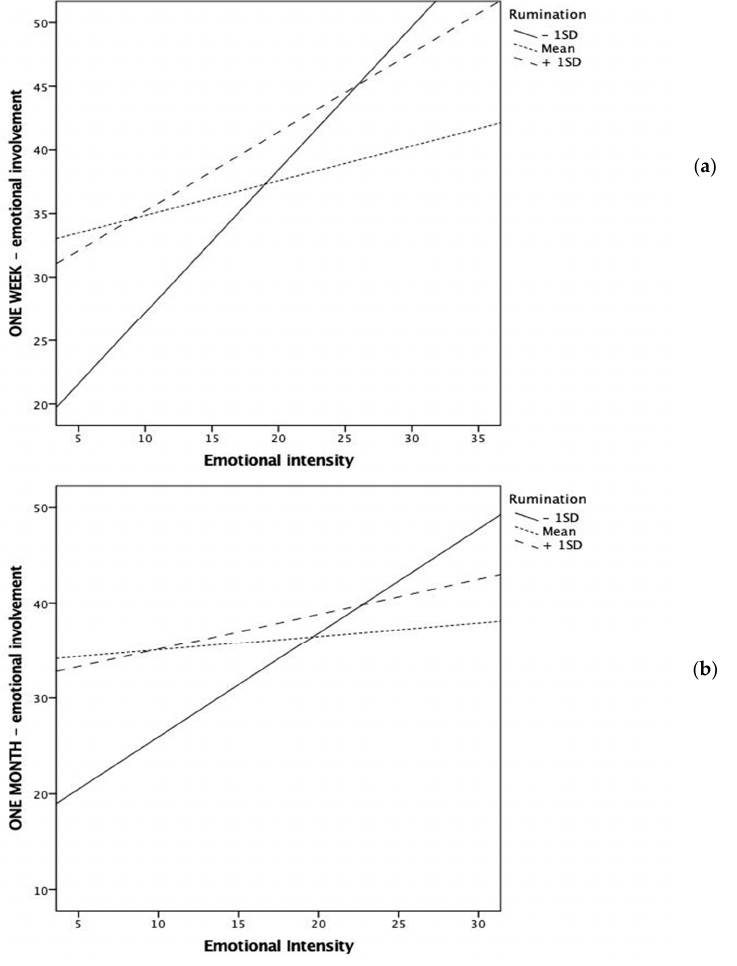
Figure 2. Graphical representation of the significant interaction between rumination and emotional intensity in predicting sensory information at one-week ( a ) and one-month ( b ) follow-up assessments. Finally, rumination was a significant moderator of the association between emotional intensity and memory clarity at the one-month assessment (Figure 3). Similar to the previous findings, low ruminators reported remembering more visual and spatial details (i.e., clarity) as the emotional intensity of the event increased. However, this association was less strong in participants adopting medium to high rates of rumination. In fact, individuals with average levels of rumination reported similar levels of clarity regardless of the emotional intensity of the